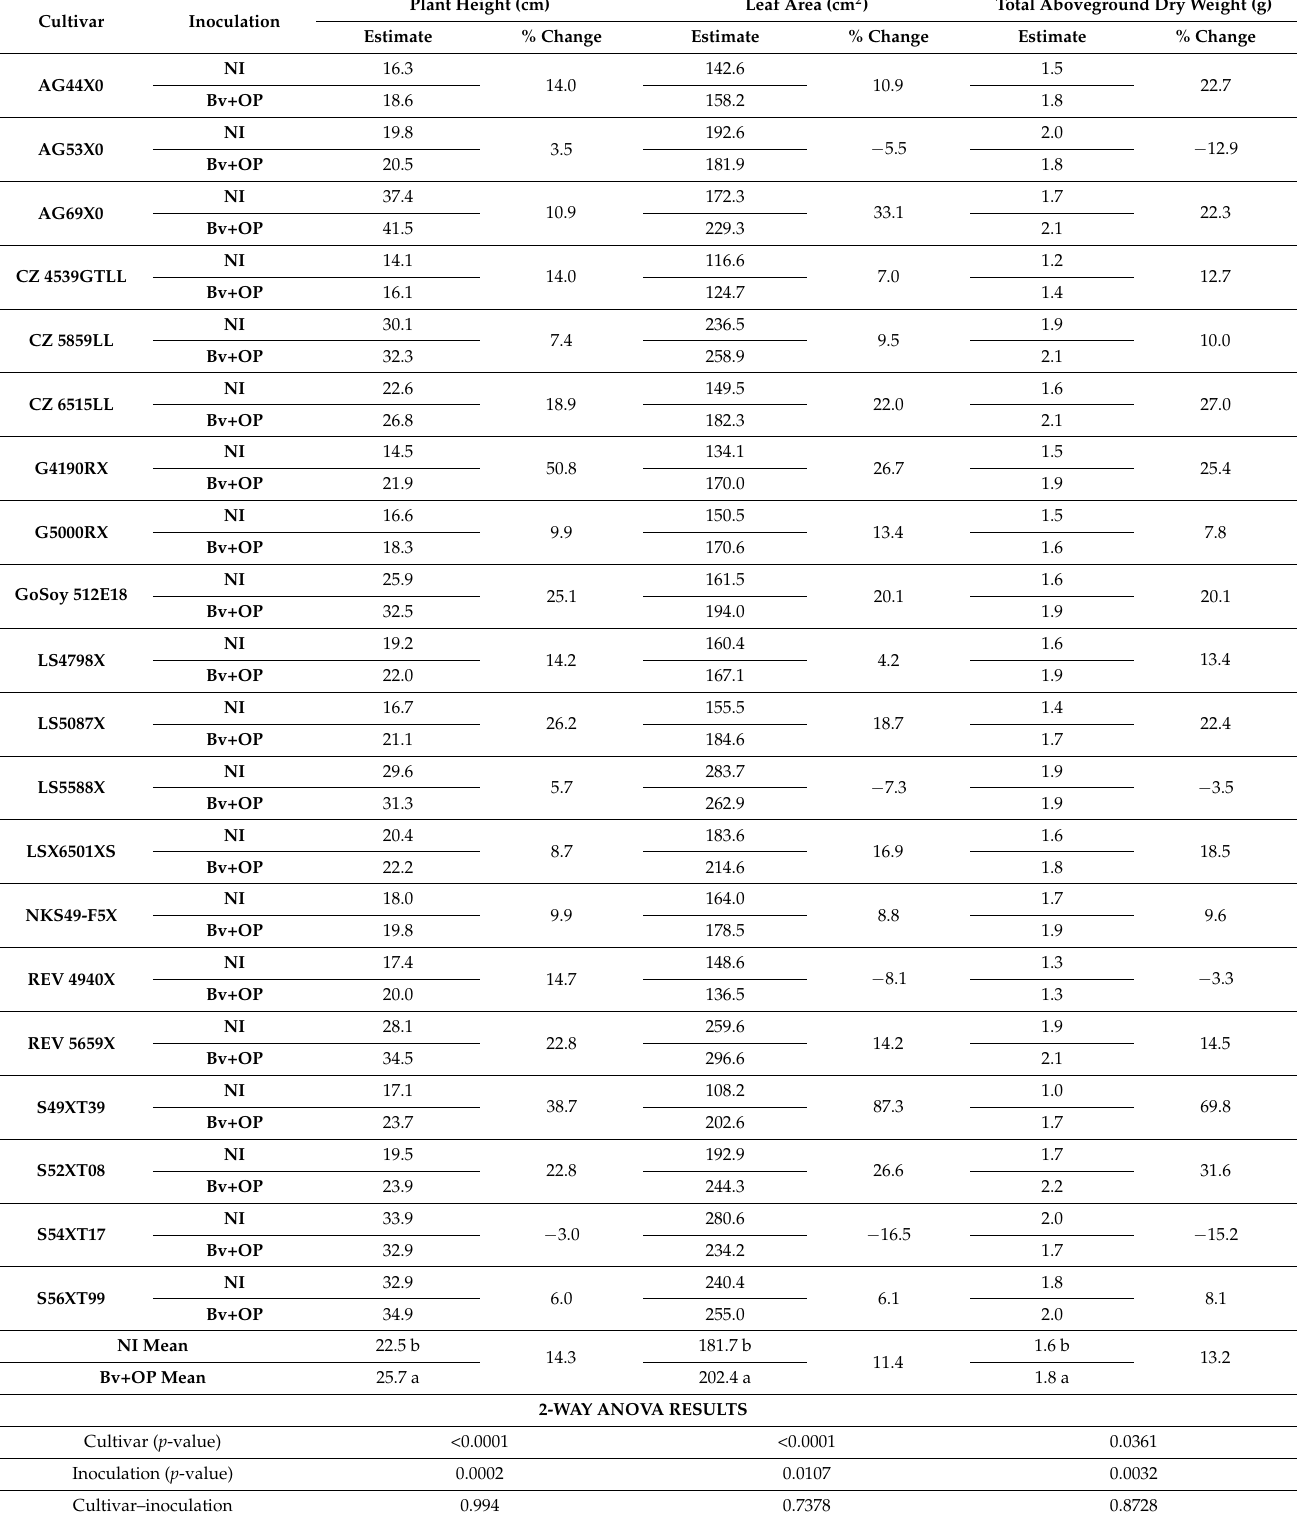
Table 1. Response of inoculation with Bv AP193 plus OP on plant height, leaf area and total aboveground biomass in a preliminary greenhouse experiment with 20 soybean cultivars. The bottom section of the table shows the ANOVA results ( p -value) for the effect of cultivar, inoculation and the interaction cultivar–inoculation. Different letters indicate significant differences within the treatment